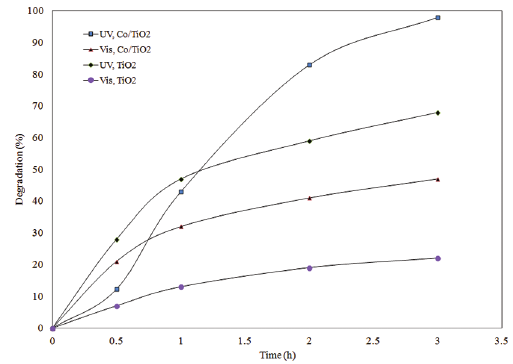
photcatalyzed degradation of methyl Figure 5: Co/TiO 2